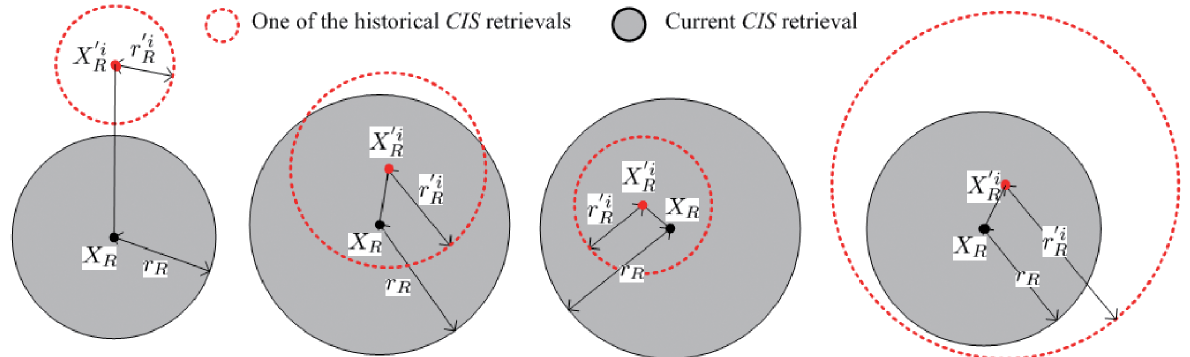
Fig 8. X AA ð Y ð X